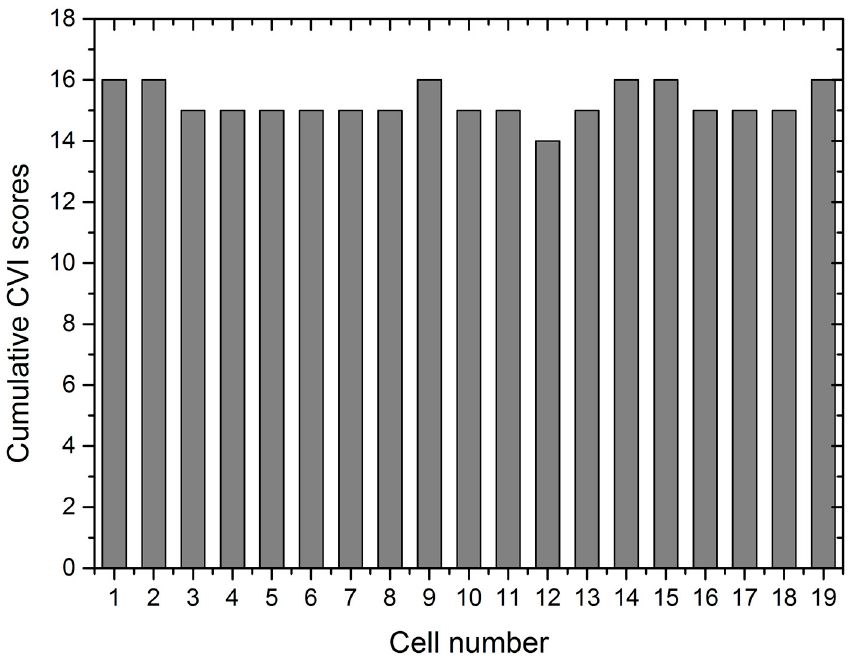
Figure 6. Aggregated CVI scores.